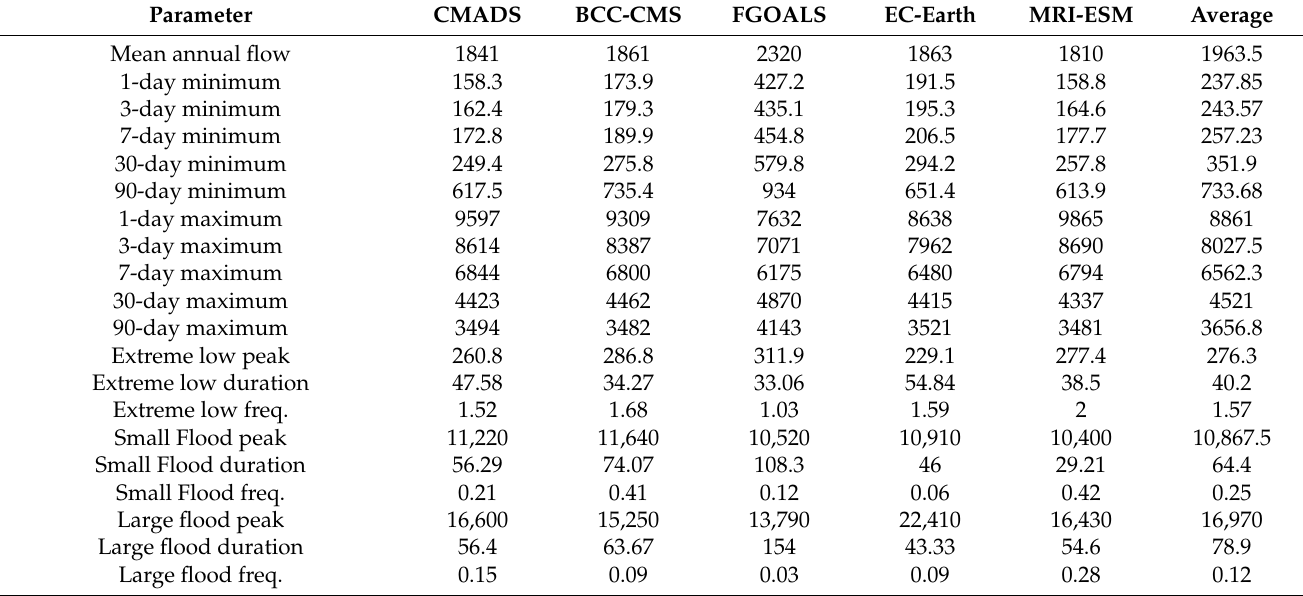
Table 7. Mean values of the actual historical (1981–2014) river flow data simulated using CMADs and GCMs precipitation